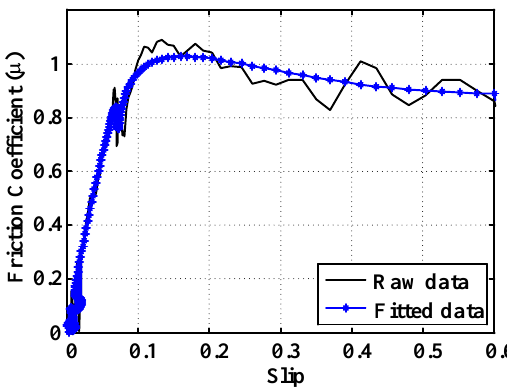
Figure 24. Experimental friction curve of the test surface.